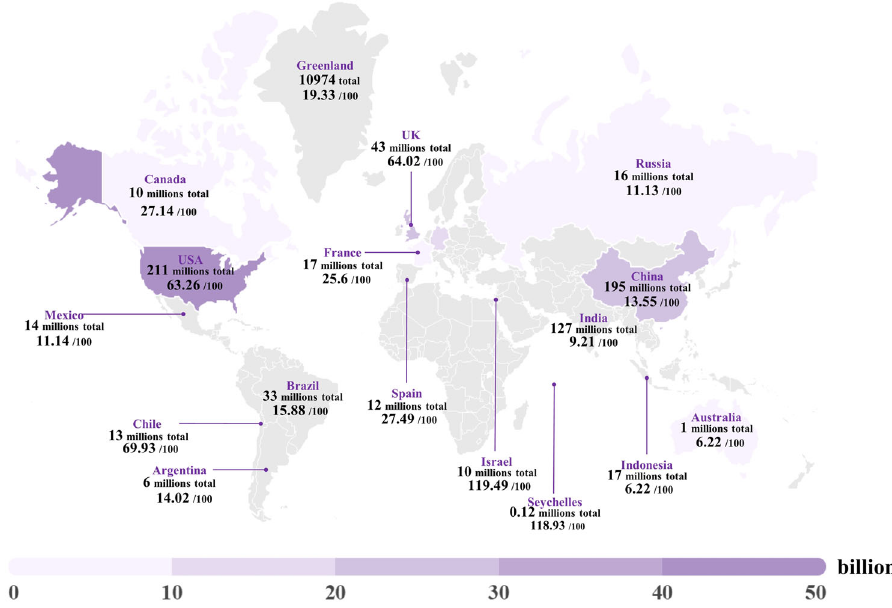
Fig. 6 Map of the estimated vaccine production capacity and vaccination status. The shades of colour on the map represent the estimated vaccine production capacity for 2021, and the legends on the map represent cumulative vaccination (vaccination doses per hundred people) through 19 April